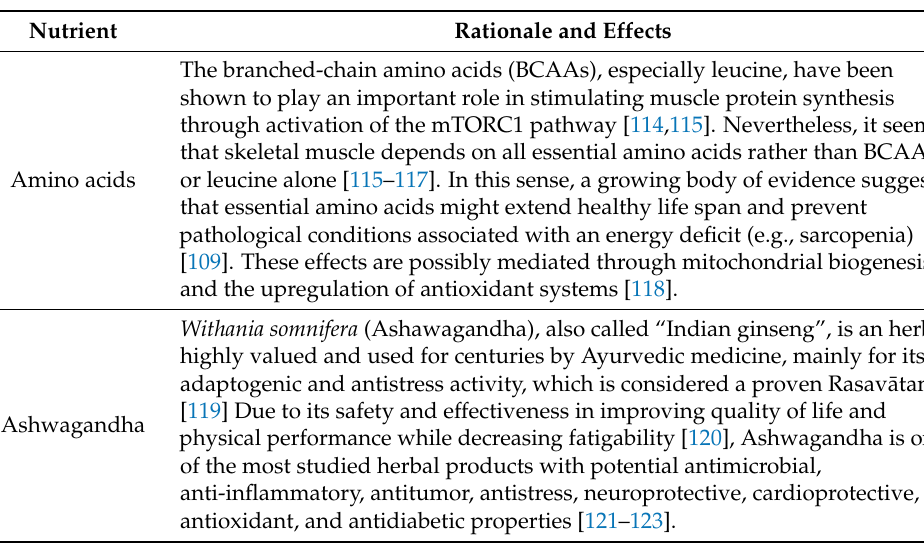
Table 1. Nutrients and their rationale in sarcopenia